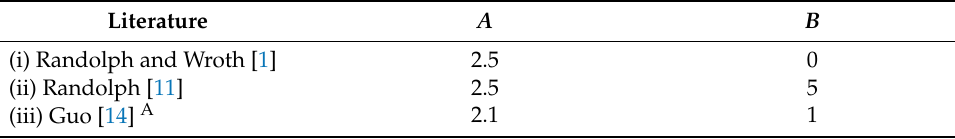
Table 1. Values for A and B (Equation (3)) under different